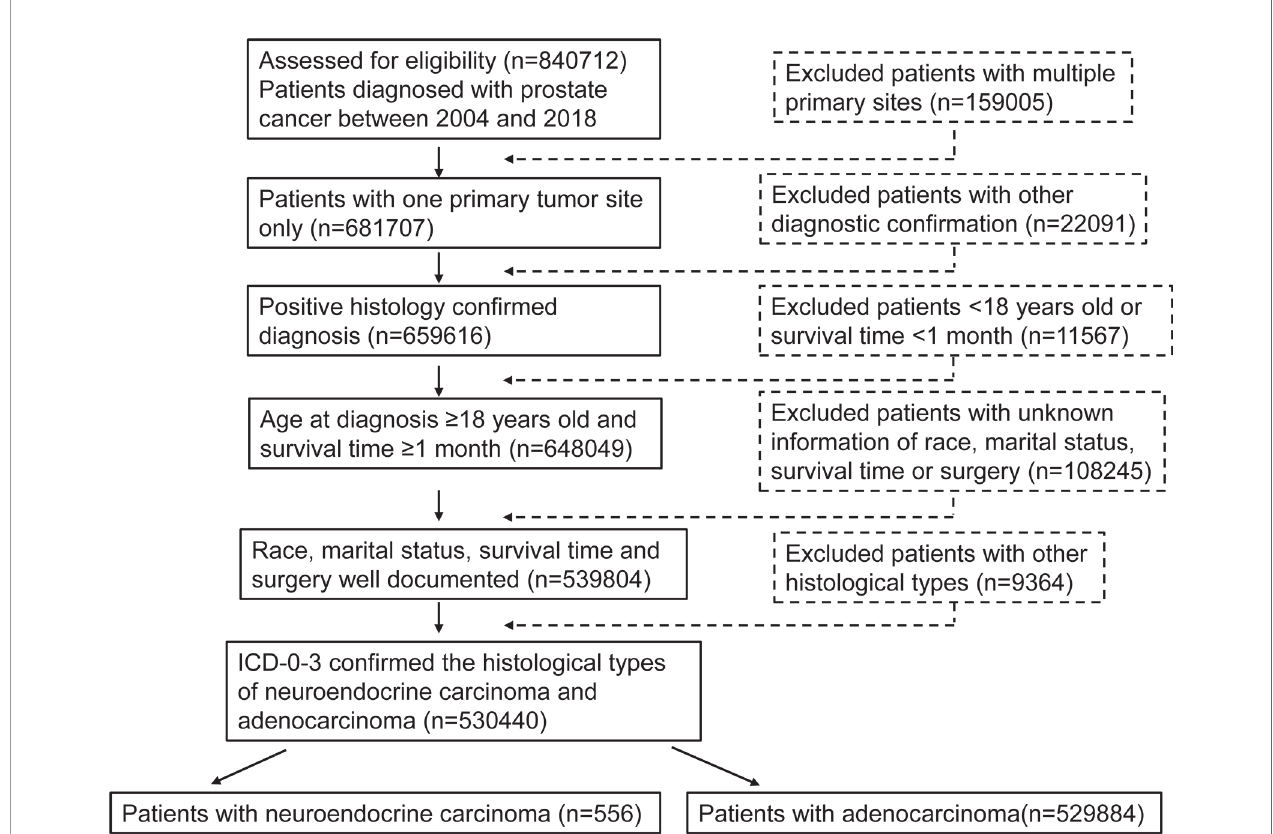
FIGURE 1 | Flowchart of patient selection